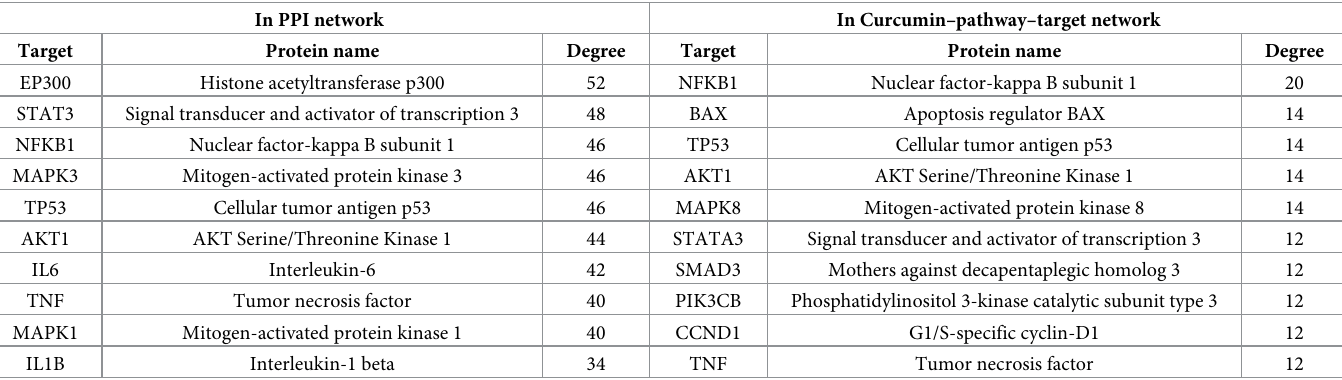
Table 1. The top 10 curcumin–IS candidate key targets according degree. In PPI network